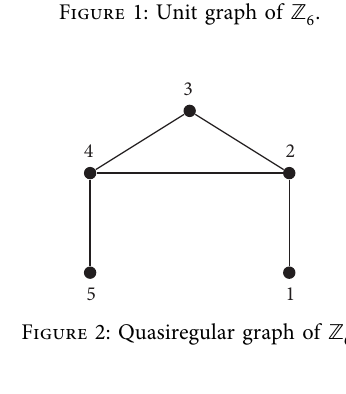
Figure 1: Unit graph of Z